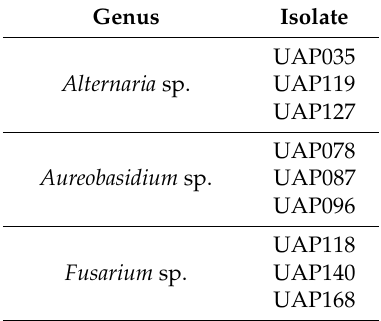
Table 2. Isolates evaluated in the pathogenesis assays and the genus phenotypically identified.